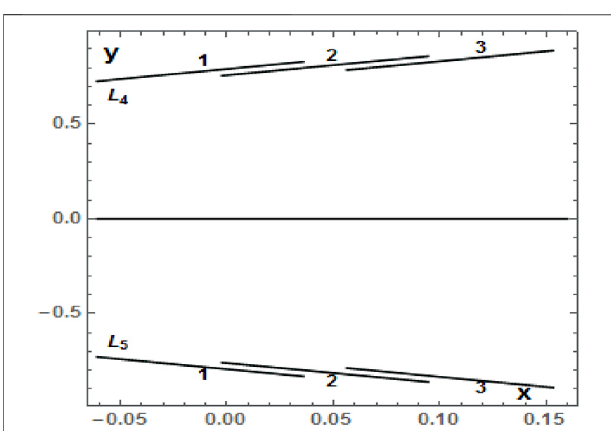
FIGURE 12 | Positions of the two triangular equilibrium points L 4 and L 5 on the xy – plane as a function of σ 1 , which varies in the interval (0.02, 0.12) for fi xed values of σ 2 equal to 0.01 (1), 0.05 (2) and 0.09 (3). The radiation pressure, oblateness, mass of the disc, and triaxiality parameters of the smaller primary are kept as constants as in the previous case (Table 9)